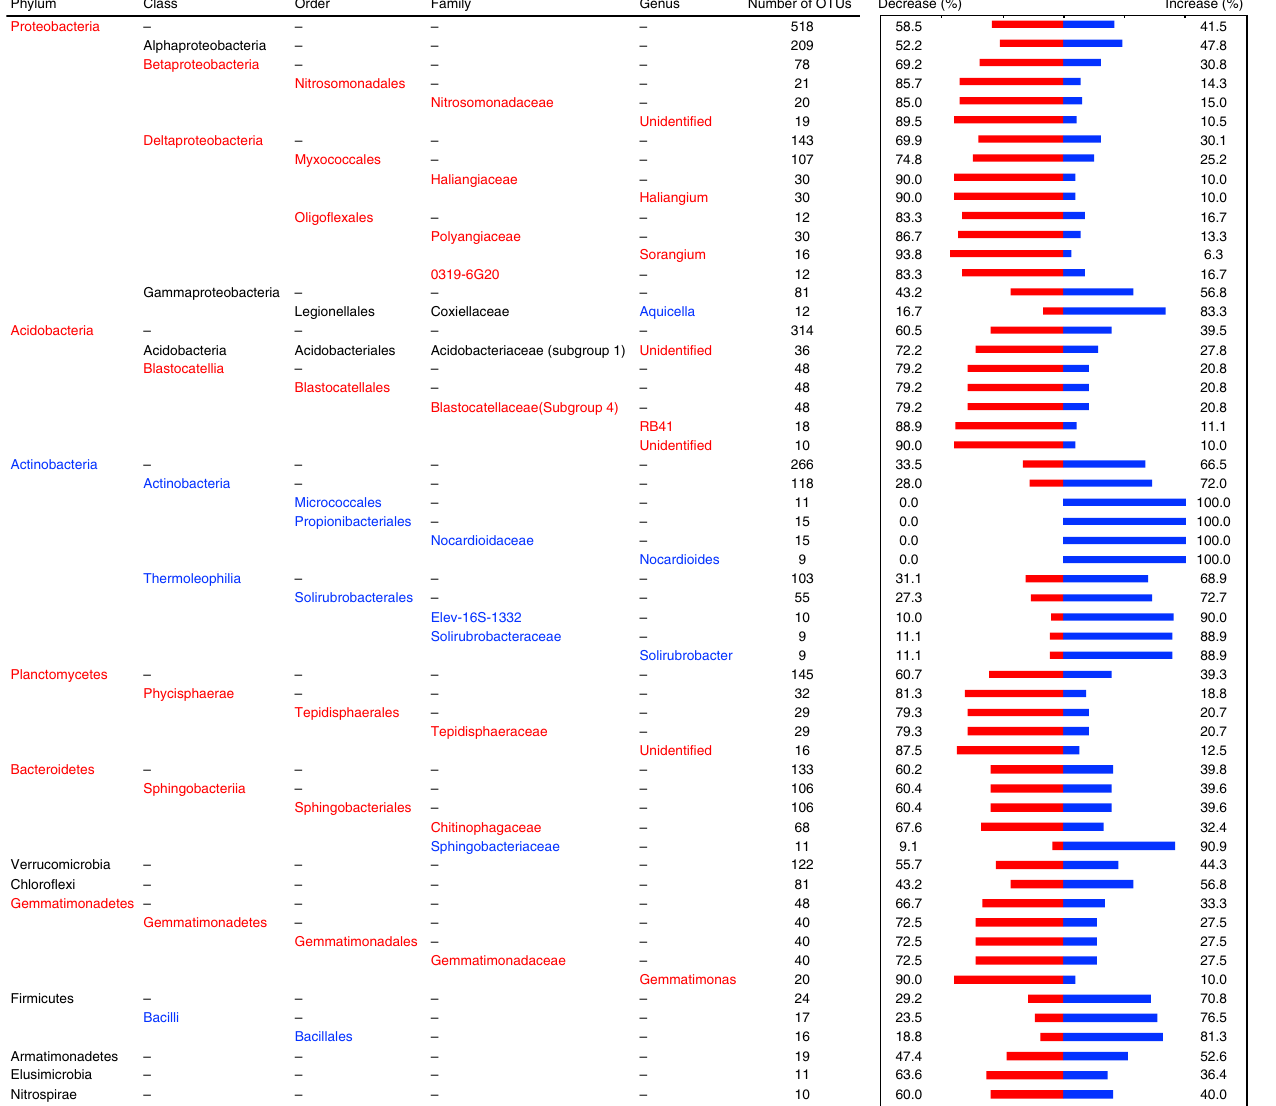
Fig. 4 Taxonomic groupings whose response to N addition was positive or negative. The response signi fi cantly more positive (blue text) or negative (red text) than expected by chance (two-tailed exact test; P <0.05), based on the response ratios of each OTU calculated in DESeq2, are shown. We also include all phyla (and classes for Proteobacteria) even if they were not signi fi cant (black text) for comparison. The percent of OTUs responding positively (blue) or negatively (red) are plotted in the bar graph to the right. Higher taxonomic levels are listed in black (e.g., the order Legionellales ) when only the lower levels are signi fi